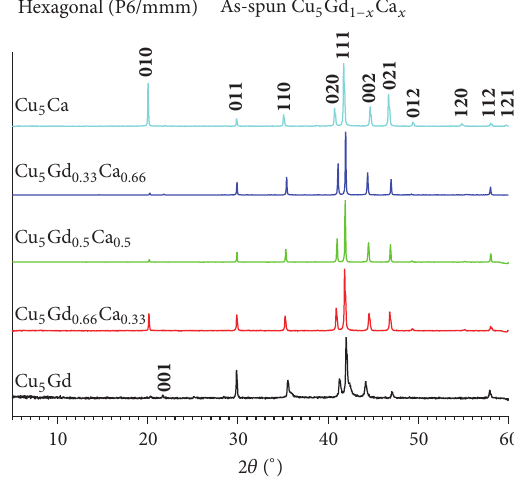
Figure 4: XRD patterns of Cu 5 Gd 1−𝑥 Ca 𝑥 ( 𝑥 = 0, 0.33, 0.5, 0.66, and 1) ribbons, melt-spun at a tangential speed of the copper wheel of 40